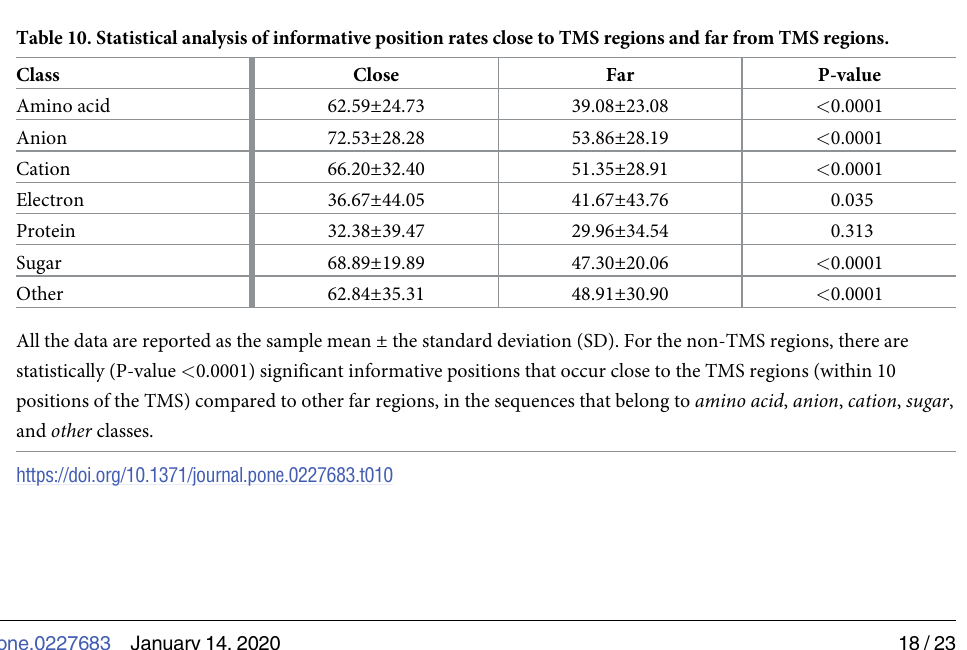
Table 10. Statistical analysis of informative position rates close to TMS regions and far from TMS regions.